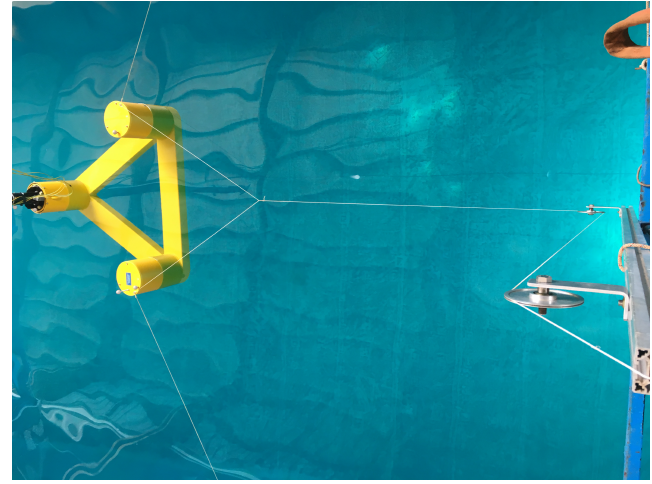
Figure 4. Photograph of a system of pulleys and wires designed for a static pull test. After the thruster is switched on it takes some time for the system to find equilibrium. As a consequence, the motions under constant thrust are not always steady and the motion offsets must be obtained from the averages over time intervals during which the thrust was supposedly constant. For some tests, the intervals without thrust were very short. This can make the average offset for the calculation of the stiffness in the first step unreliable. The offsets extracted from the measurements and the stiffness coefficients in surge and pitch are presented in Figure 5.